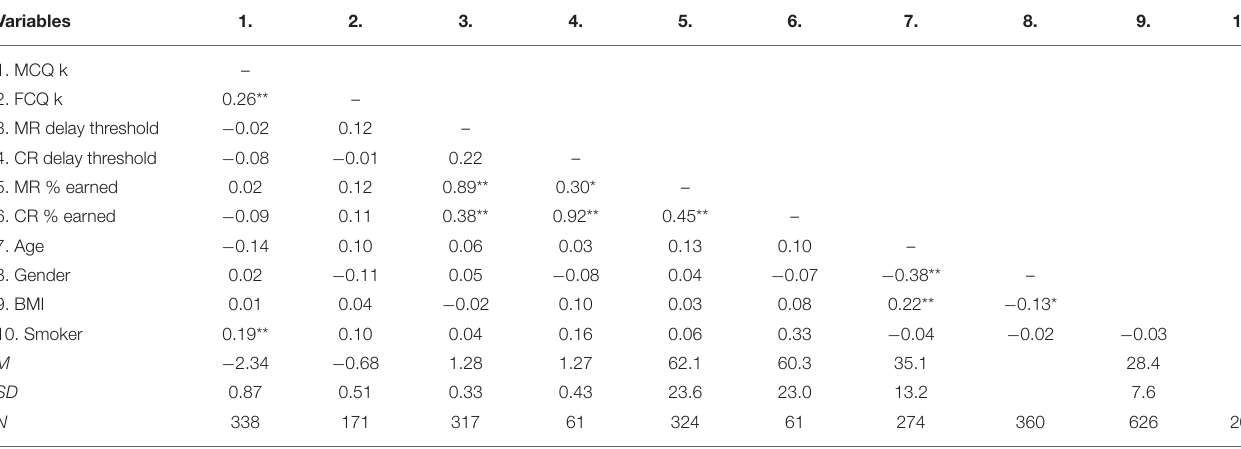
TABLE 1 | Correlation between discounting rates (log 10 k) and row task performance.